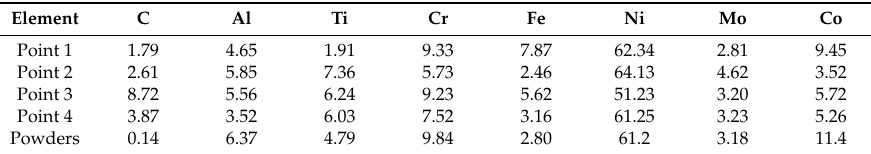
Table 2. Elements’ concentration of different test points (mass fraction